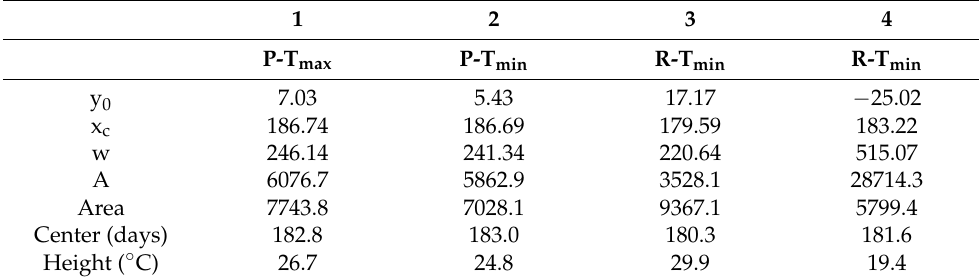
Table 1. Gaussian behavior parameters of the PET